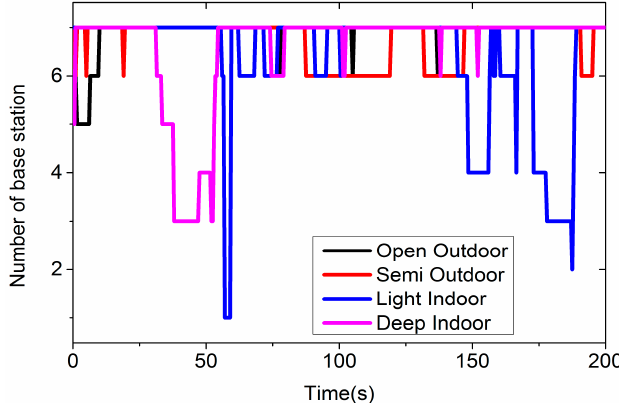
Figure 4. The number of cellular base stations in different environments.